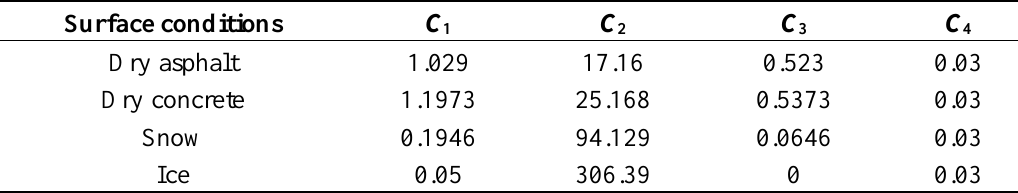
Table 1. Tire-road friction